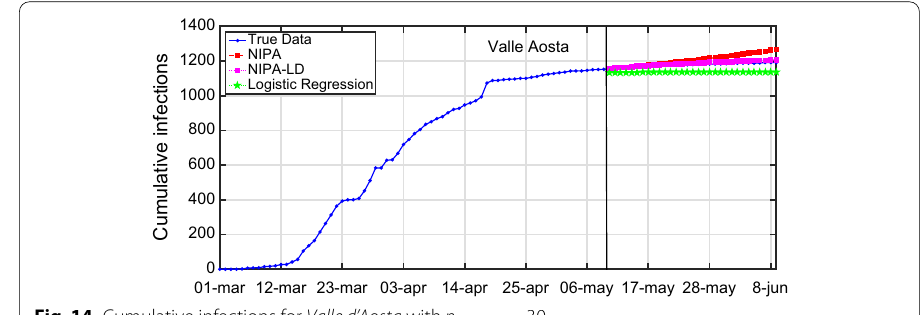
Fig. 14 Cumulative infections for Valle d’Aosta with n neglect = 30